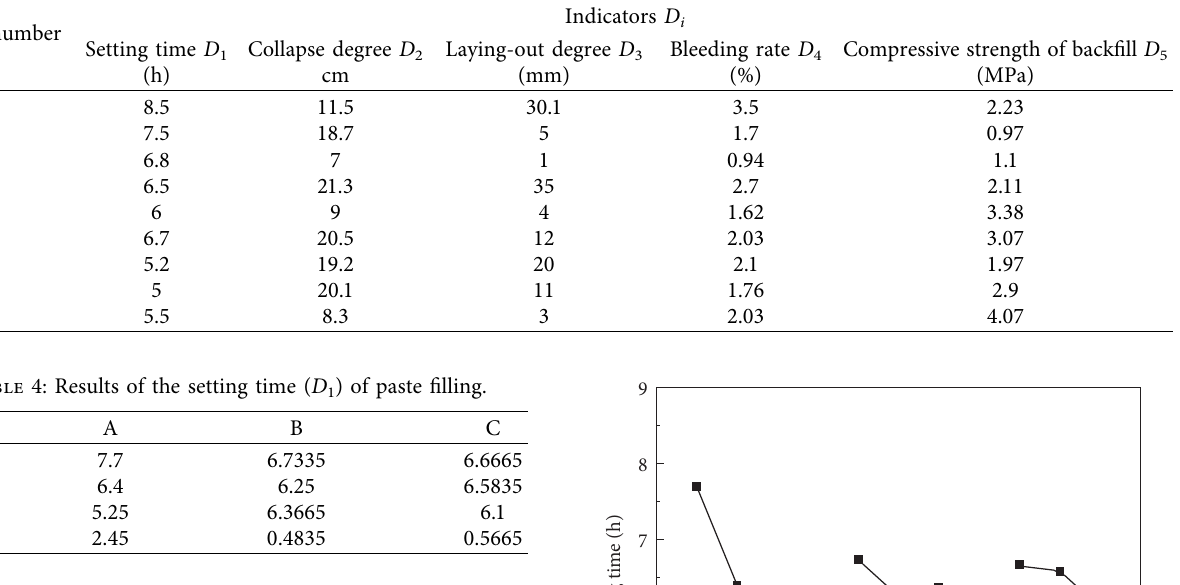
3 ) orthogonal test. 9 (3